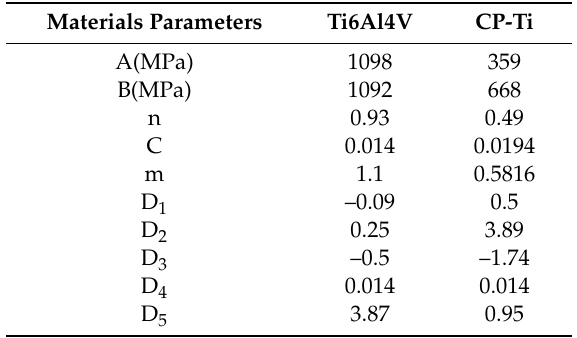
Table 3. Johnson–Cook material constants of Ti6Al4V and